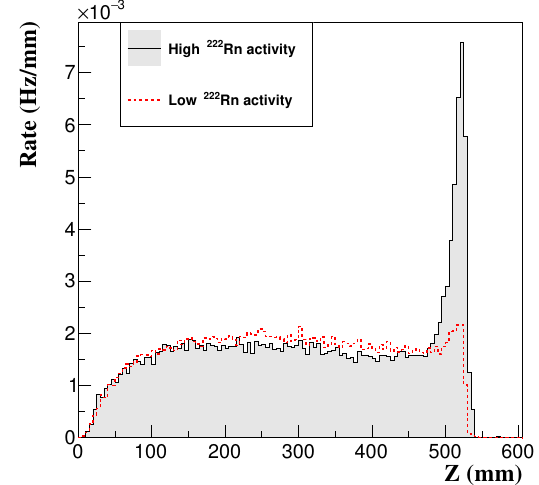
Figure 7 . Radon-induced electron background rate as a function of Z , for the two run periods described in table 3.